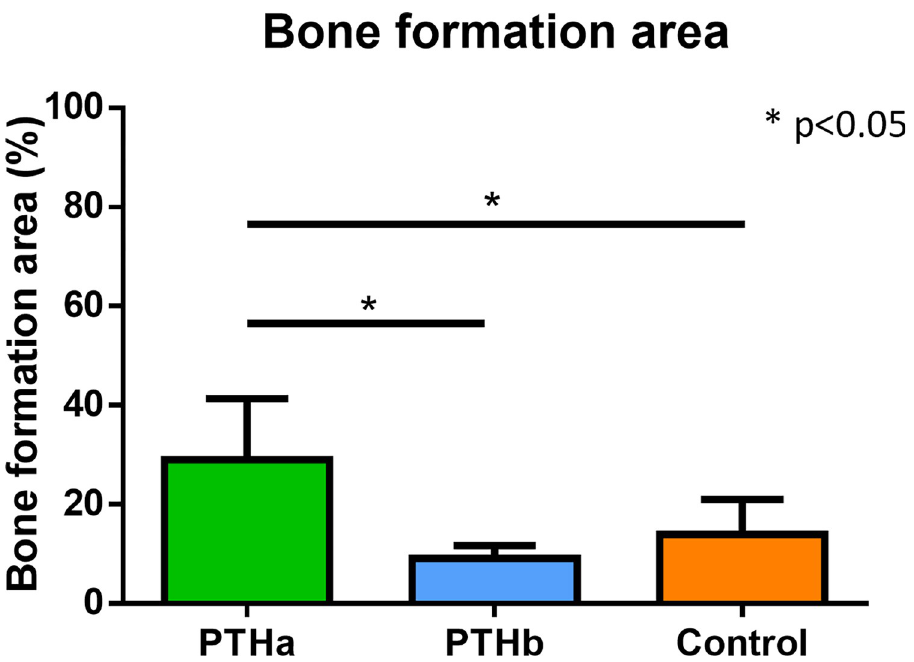
Fig 10. Bone formation area. The ratio of bone formation was significantly higher in the PTHa group than in the PTHb and Control groups. There was no significant difference between the PTHb and Control groups.